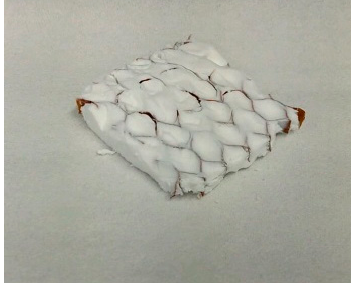
Figure 9. Low-flexible silica aerogel (SA2) with aramid honeycombs C1-6.4-24.